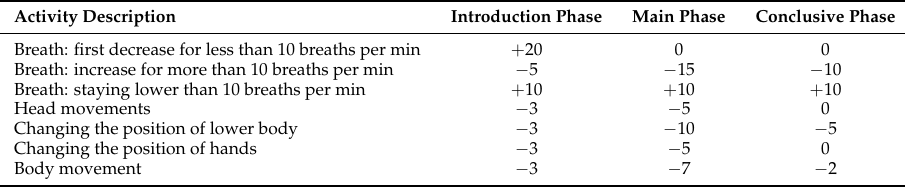
Table 2. The evaluation parameters and their